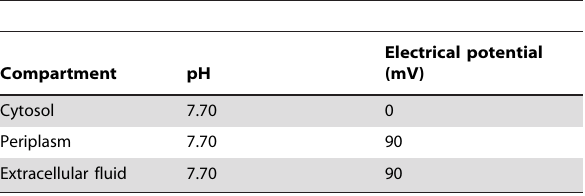
Table 1. pH and electrical potential in each compartment of the E. coli reconstruction iAF1260.